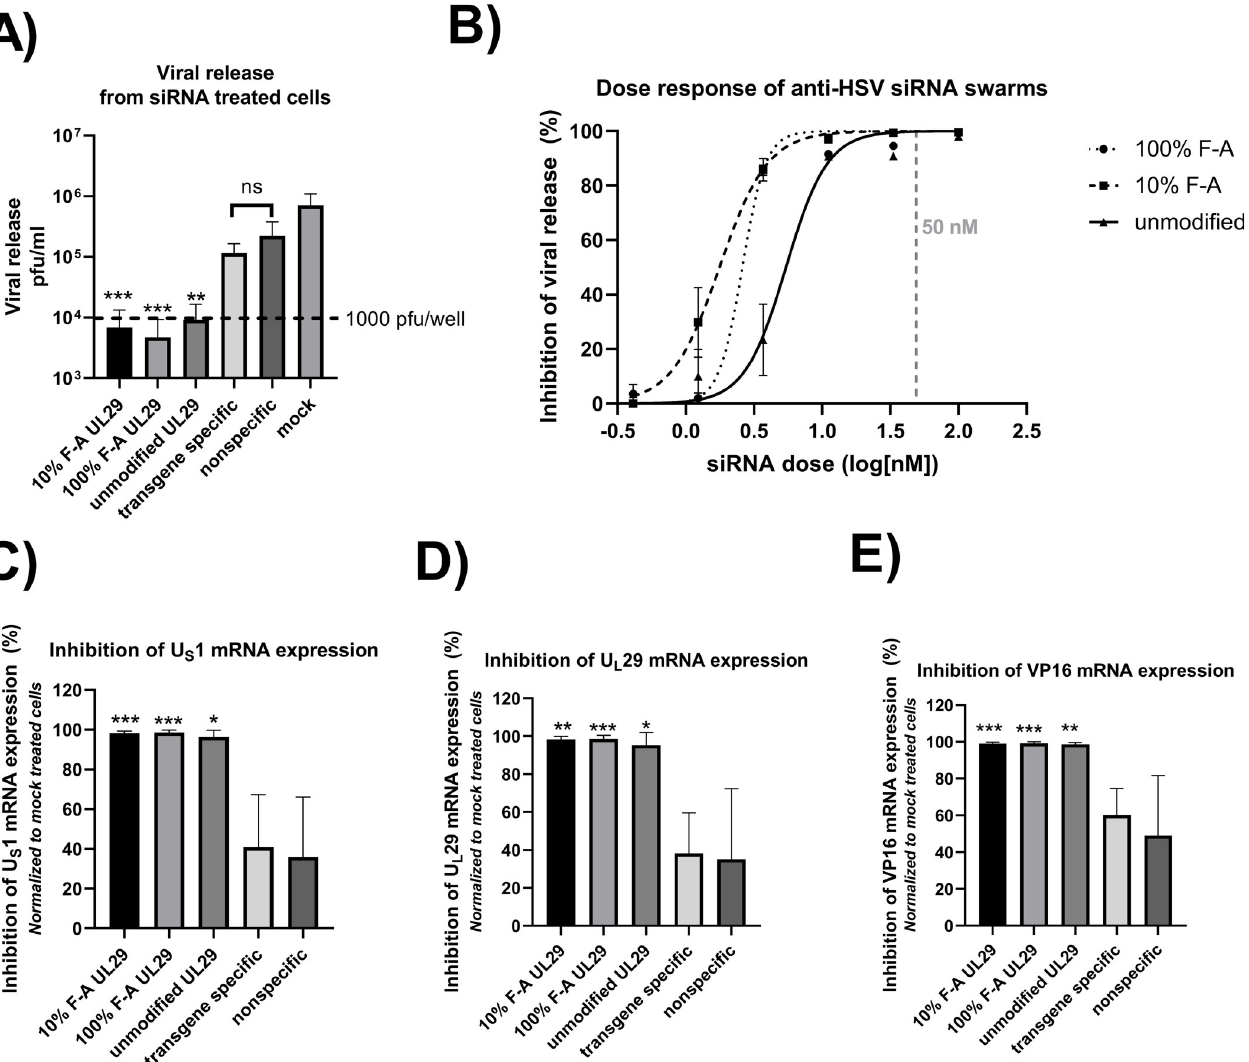
Fig 1. Antiviral activity of the siRNA swarms in human corneal epithelial cells. Human corneal epithelial (HCE) cells were transfected with the indicated siRNAs and infected with 1000 pfu of HSV-1-GFP four hours post transfection (hpt). At 48 hpt, samples were taken for the quantification of viral release (shedding) using plaque assay ( A and B ) and to measure viral mRNA expression ( C – E ).Both unmodified and modified anti-HSV UL29-siRNA swarms were used. The adenosine residues in the antisense strand of the 2’-fluoro modified siRNA swarms were either partially (referred to as 10% F-A) or fully (referred to as 100% F-A) modified. The controls in panels A and C – E include a transgene specific siRNA swarm, targeting the nonessential GFP insert of HSV-1-GFP, nonspecific siRNA swarm, targeting no gene present in the target cells nor in the virus, and mock treatment, referring to transfection reagent without any RNA. (A) Quantitation of viral release. HCE cells were treated with 5 pmols per well (50 nM) of the indicated siRNA swarms and infected 4 hpt with 1000 pfu of HSV-1-GFP per well. The column represents the mean and the whiskers the standard deviation of the treatment group. The data is from two independent experiments with a total of 8 replicates. The virus concentration representing the input virus amount of 1000 pfu/well in 100 μ l, equaling to 10 4 pfu/ml is indicated in the Fig 1A as a horizontal line (—). (B) Impact of siRNA dose on viral release. HCE cells were treated with a dose range of 0.41 to 100 nM (0.041 to 10 pmol per well, three-fold dilution series) of each indicated anti-HSV siRNA swarm and infected with 1000 pfu per well (96 well-plate) of HSV-1-GFP at 4 hpt. The error bars mark the standard error of mean (SEM) and the dashed line marks the 50 nM dose (5 pmols/well) used in all other panels. (C-E) HCE cells were treated with 50 nM of the indicated siRNA swarms and infected with 1000 pfu per well of HSV-1-GFP at 4 hpt. At 48 hpt, the cells were collected for quantitative reverse transcription PCR (RT-qPCR) analysis for the expression of three viral lytic genes, U S 1, U L 29, and U L 48, encoding for the viral factors ICP22, ICP8, and VP16, respectively. The data is shown as percentage of the relative mRNA expression in comparison to the mock treated samples. The column represents the mean and the whiskers the standard deviation of the treatment group. The data is derived from two separate experiments, in which there were four biological replicates for each treatment group. In panels A and C - E , statistical significance is shown against mock treated samples ( � p < 0.05, �� p < 0.01, ��� p < 0.001).